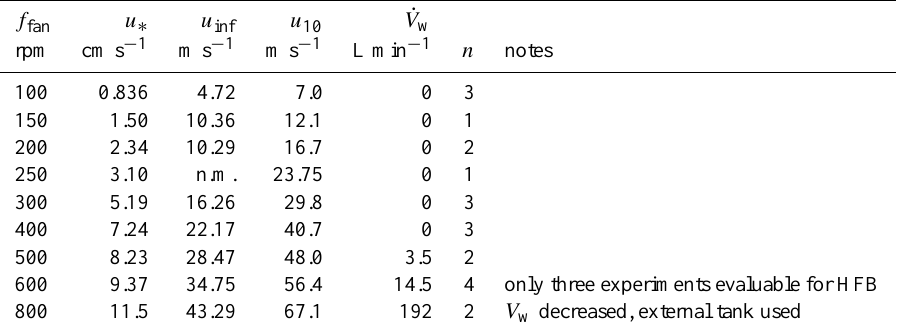
Table 2. Experimental conditions used at the Kyoto high-speed wind-wave tank. f fan is the frequency of the wind-generating fan, u ∗ is the friction velocity, u inf denotes the free-stream velocity, and u 10 is the wind speed at 10m height. ˙ V w is the leak rate. The number of repetitions of each of the conditions is labeled with n . One free-stream velocity u inf was not measured (n.m.). f fan u ∗ u inf notes